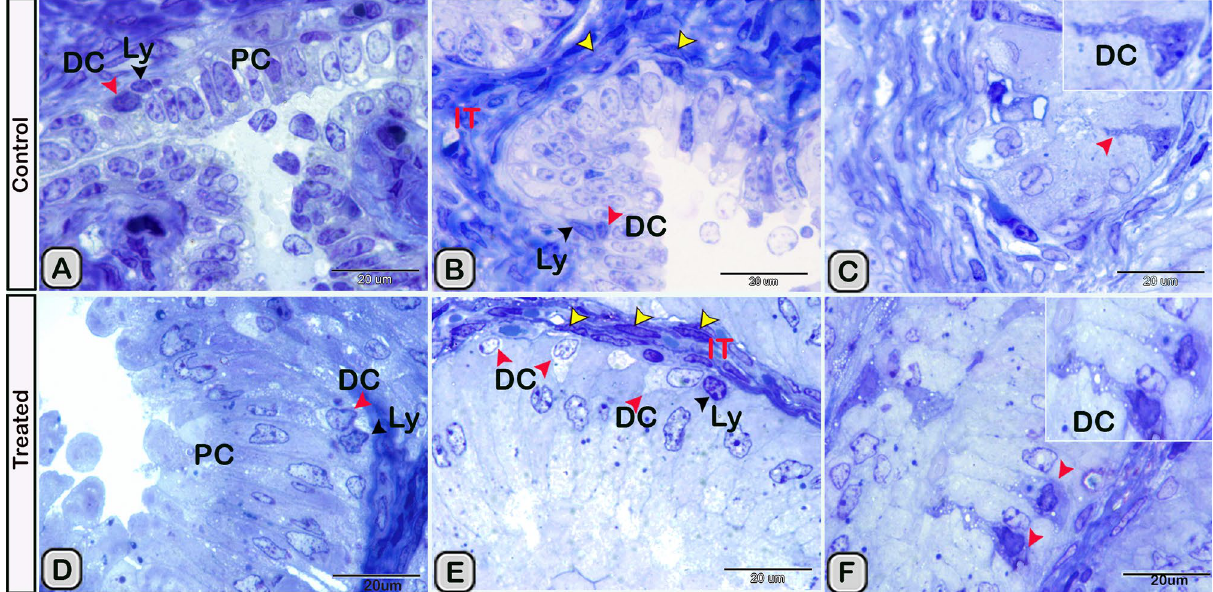
Figure 2. (A,B) Semi-thin sections stained with Toluidine blue showing the DCs (red arrowheads) in the control groups near the basement membrane lining the glandular epithelium and its close association to T- lymphocytes (black arrowhead) and telocytes (TCs, yellow arrowheads) in the interstitium (IT). (C) A triangular-shaped dendritic cell with a few vesicles in the cytoplasm and a long cytoplasmic process directed toward the lumen of the gland was observed. (D,E) In the melatonin treated groups, DCs (red arrowheads) were closely associated to T-lymphocytes (Ly, black arrowheads) and telocytes (yellow arrowheads) in the interstitium (IT). DCs were larger in size and their nucleus was euchromatic and more indented in comparison to control groups. Notice, the epithelium of the principal cells (PC) is higher in melatonin groups compared to control ones. (F) The cytoplasm of dendritic cells had large amount of the secretory vesicles in comparison to the control groups.